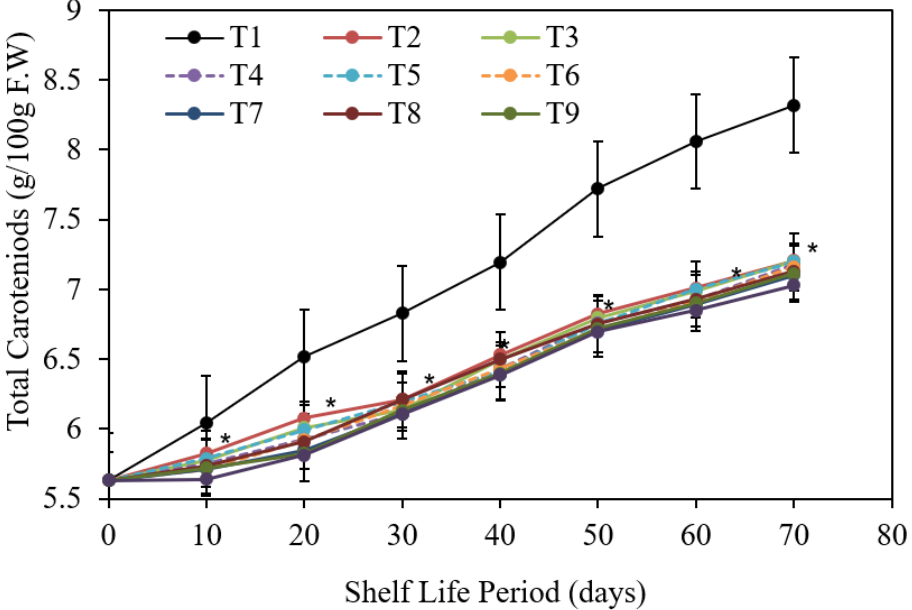
Figure 15. The impact of pre-harvest chitosan, chitosan nanoparticle, and CaCl 2 foliar spray treatments on total carotenoids content of Barhi date fruits under cold storing for 70 d. Note that * sign denotes the significant differences between the control and edible coatings treatments, and T1, T2, T3, T4, T5, T6, T7, T8, T9, T10 are water (control), 1 g/L chitosan, 2 g/L chitosan, 3 g/L chitosan, 1 g/L chitosan nanoparticles, 2 g/L chitosan nanoparticles, and 3 g/L chitosan nanoparticles treatments, respectively.